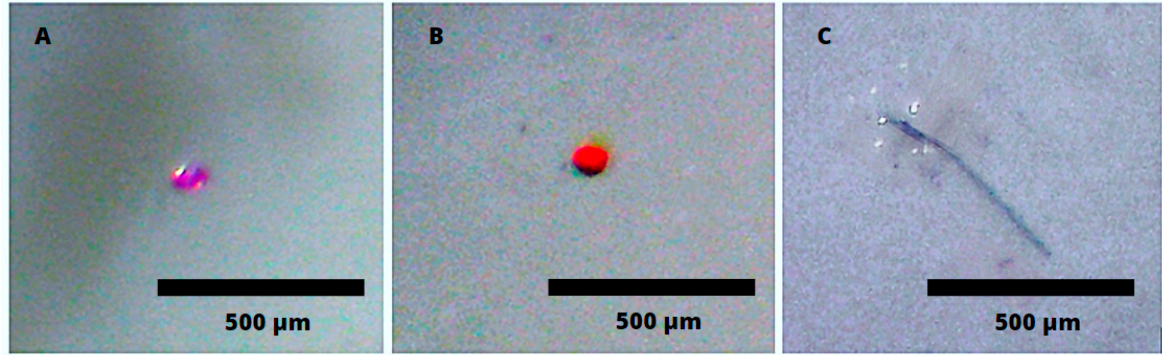
Figure 1. Spiked microplastics: pink PET fragment ( A ), orange PVC fragment ( B ); green nylon fiber ( C ).